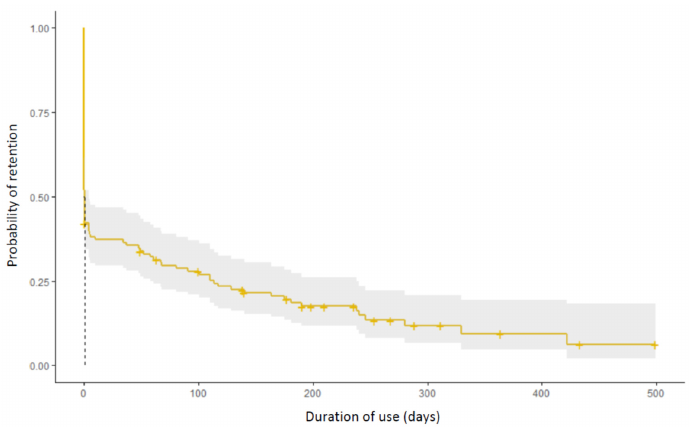
Figure 3. Estimated retention rate using the Kaplan–Meier method. Yellow line: probability of retention. Grey zone, 95% confidence interval, dotted line: median duration of use.